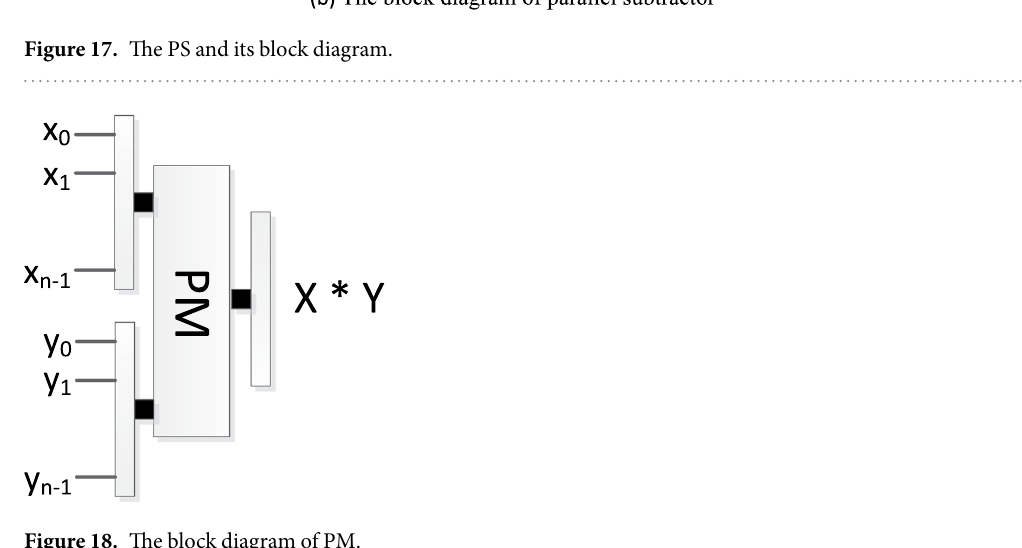
Figure 18. The block diagram of